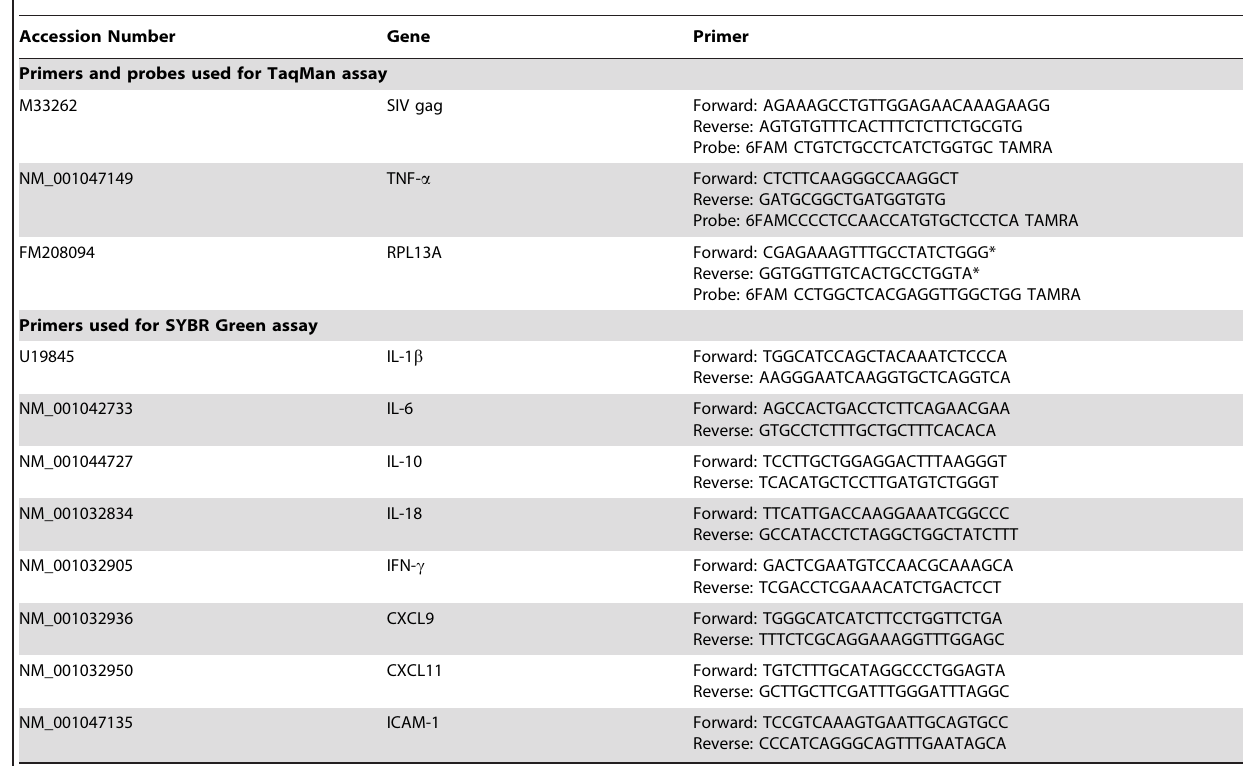
Table 3. Primers and